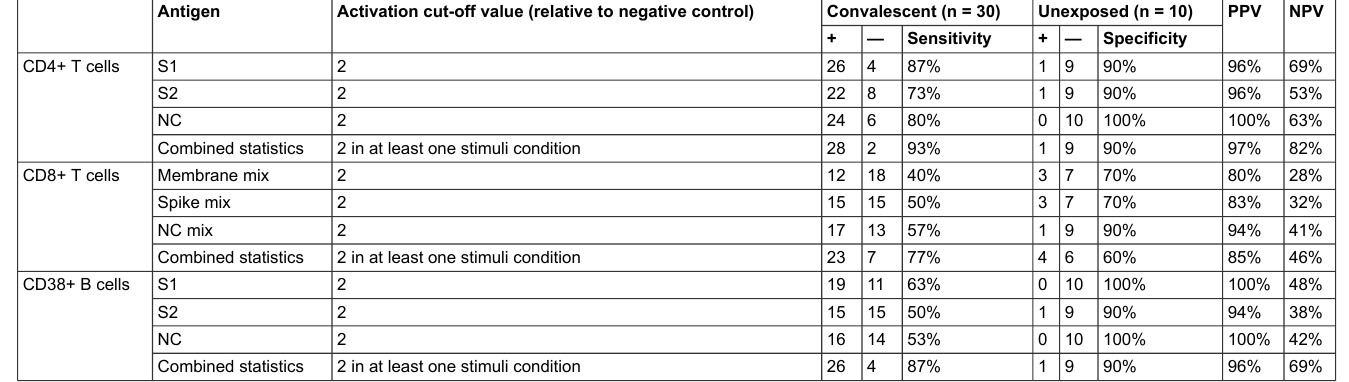
Table 2: Diagnostic values of the SARS-CoV-2 lymphocytes analysis. Sensitivity and specificity of the SARS-CoV-2 lymphocytes analysis against SARS-CoV-2 antigens covering the spike (S1 and S2), nucleocapsid (NC) and membrane proteins. Activation cut-off value is measured as the upregulation of CD134+ CD137+ for helper CD4 T cells, CD69+ CD137+ for cytotoxic CD8 T cells and CD38+ for B cells relative to the culture medium and DMSO negative controls.